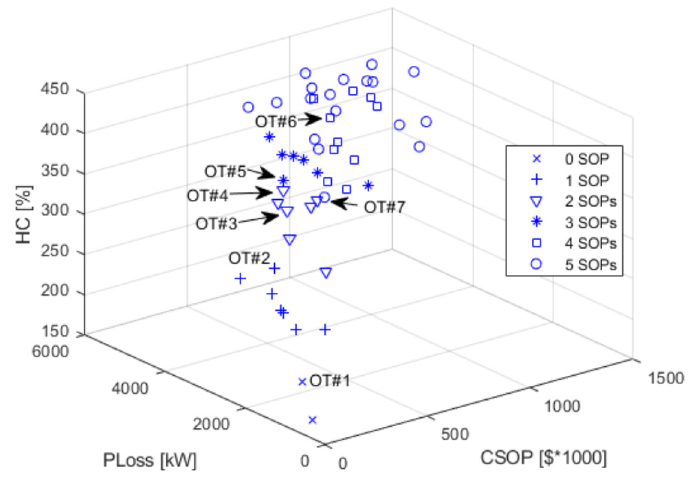
Figure 12. Pareto front of Case 4.